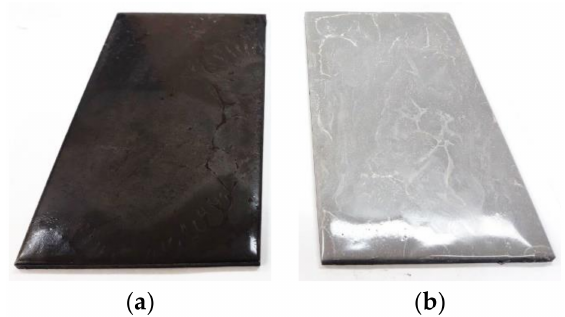
Figure 2. Fabricated specimens of the coating layers: ( a ) epoxy A ( b ) epoxy